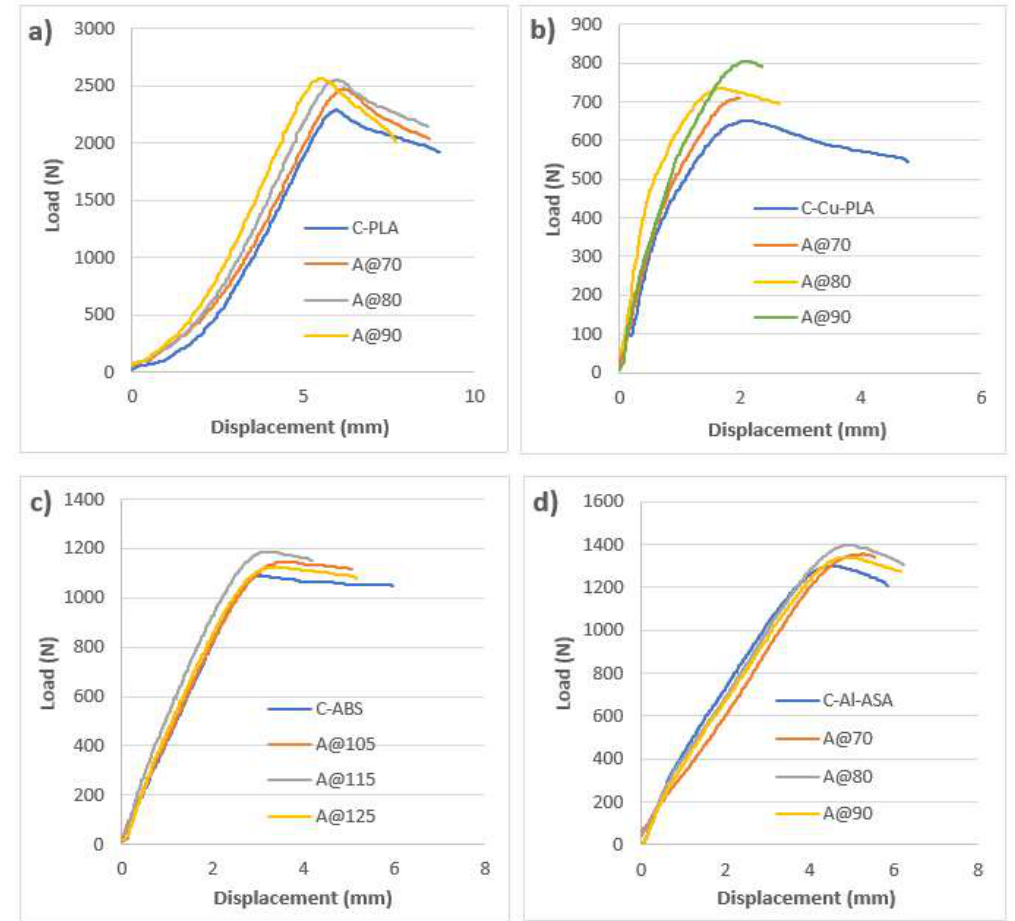
Figure 10. Results from tensile testing: ( a ) PLA material; ( b ) Cu-PLA material; ( c ) ABS material; ( d ) Al-ASA material.